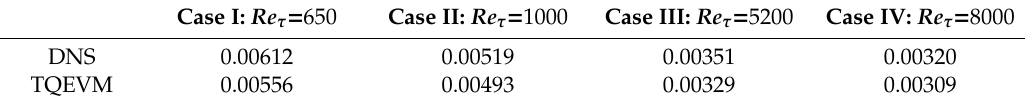
Table 2. Comparison of skin friction coefficients by TQEVM and DNS for four given cases.